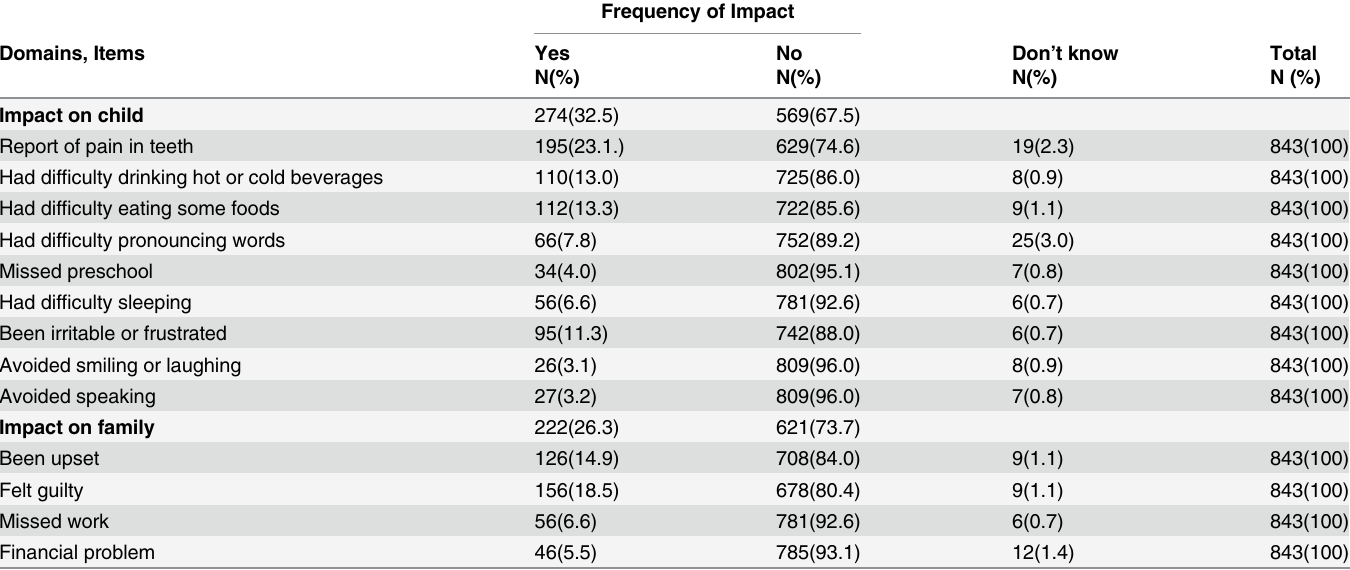
Table 2. Frequency of perceived impact on child, family and B-ECOHIS